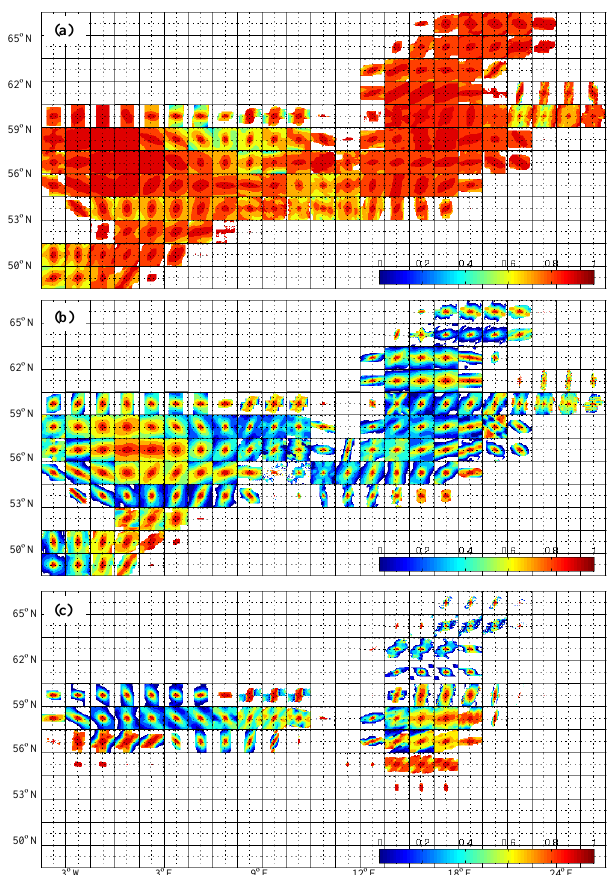
Figure 4, Contours of the spatial bin-averaged correlations in 1.5 ° X1.5 ° bins calculated from the proxy ocean Fig. 4. Contours of the spatial bin-averaged correlations in 1 . 5 ◦ × data at (a) surface, (b) 30 m and (c) 75 m for temperature. 1 . 5 ◦ bins calculated from the proxy ocean data at (a) surface, (b) 30m and (c) 75m for